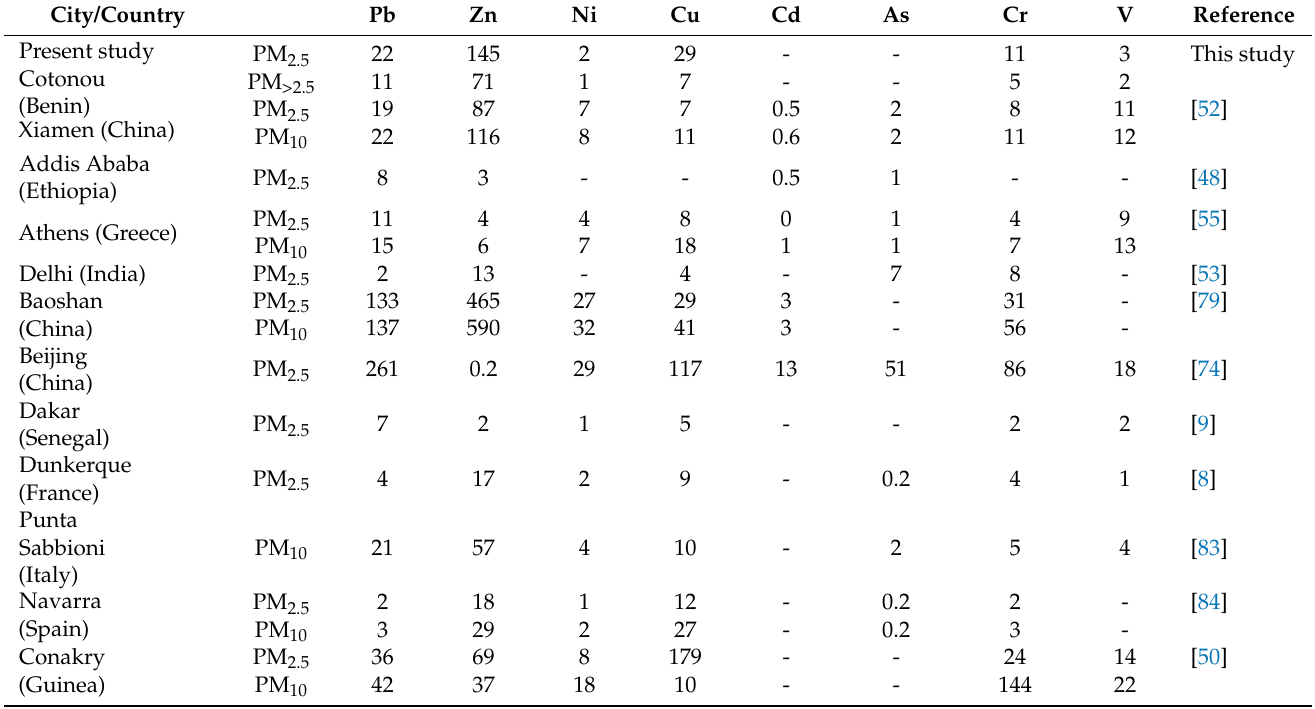
Table 3. Concentration of heavy metals (ng/m 3 ) in the ambient air of urban areas in different countries around the world.